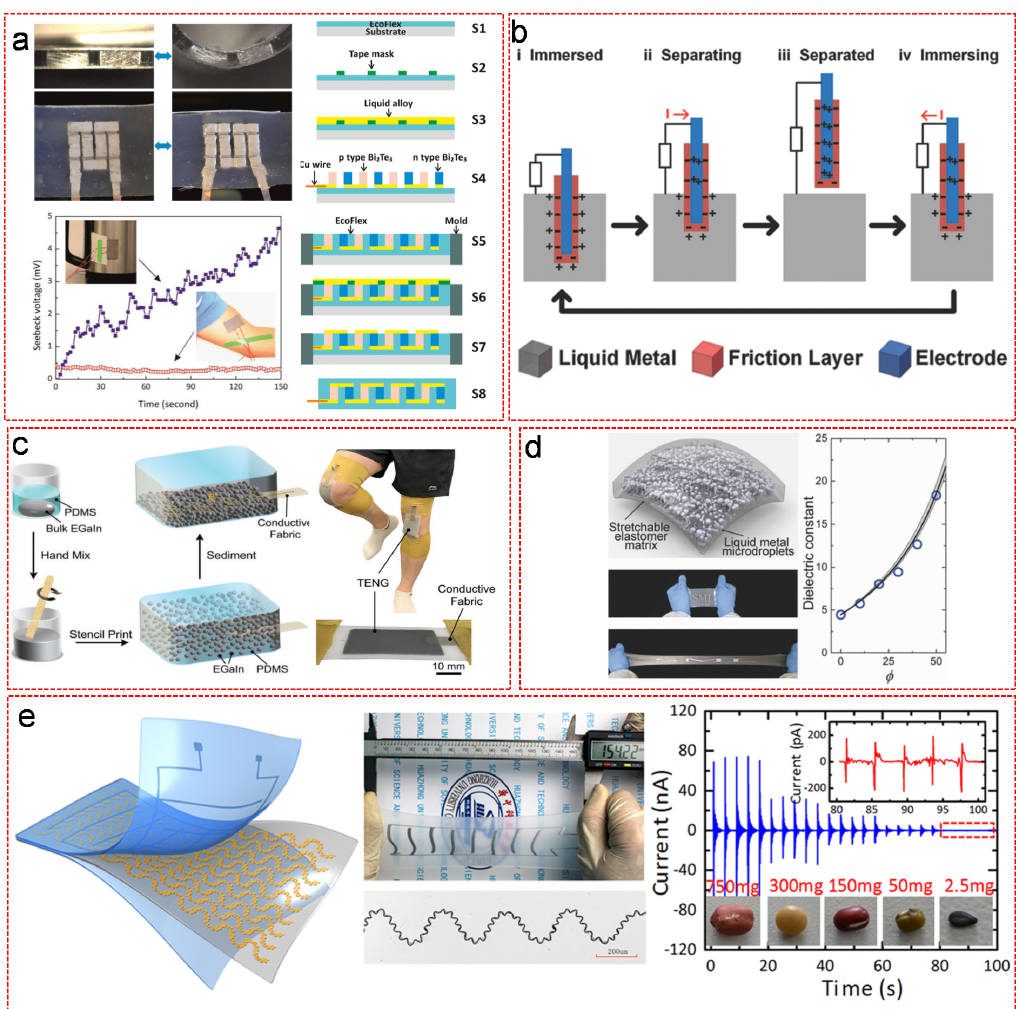
Figure 10. Various types of wearable energy harvesters based on different energy conversion mechanisms. ( a ) The schematic demonstration and photographs of a tailored layer-by-layer fabrication process of LM based highly stretchable, wearable TEG with high stability during mechanical deformation. Reproduced with permission. [119] Copyright 2017, American Chemical Society. ( b ) The working principle of LM based TENG. Reproduced with permission. [123] Copyright 2015, Wiley-VCH. ( c ) Ultrastretchable, wearable, skin-like TENG using sedimented LMEE as both the electrode and dielectric materials. Reproduced with permission. [124] Copyright 2020, Wiley-VCH. ( d ) The photographs of stretchable, high-k DEG using LMEE as the dielectric material. The dielectric properties of the LMEE are highly dependent on the fraction of LM. Reproduced with permission. [129] Copyright 2016, Wiley-VCH. ( e ) A hyper-stretchable self-powered PEG with 0.2 mg low detection limit and 1400 cycles’ stability test. Reproduced with permission. [138] Copyright 2017, Elsevier B.V.